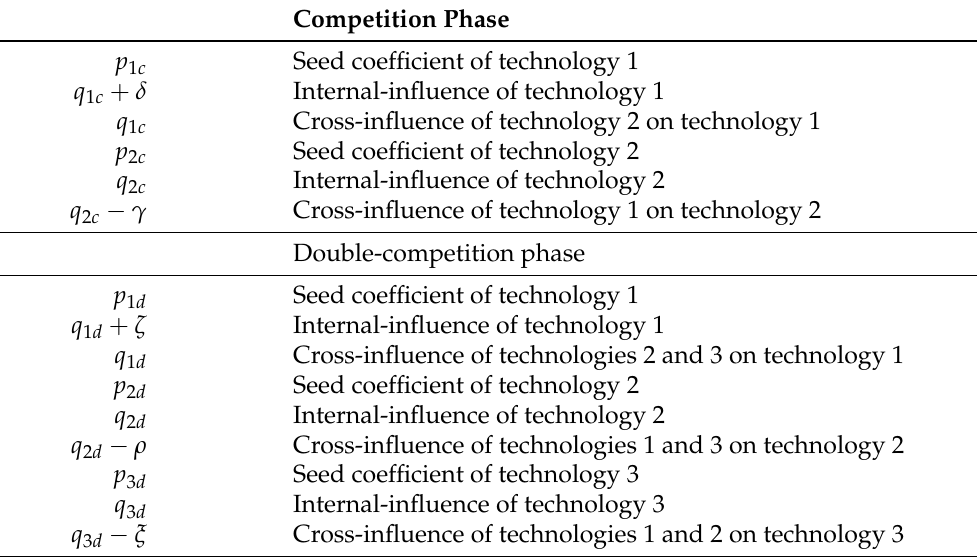
Table 1. Parameters of the UCTT model (competition phase and double-competition